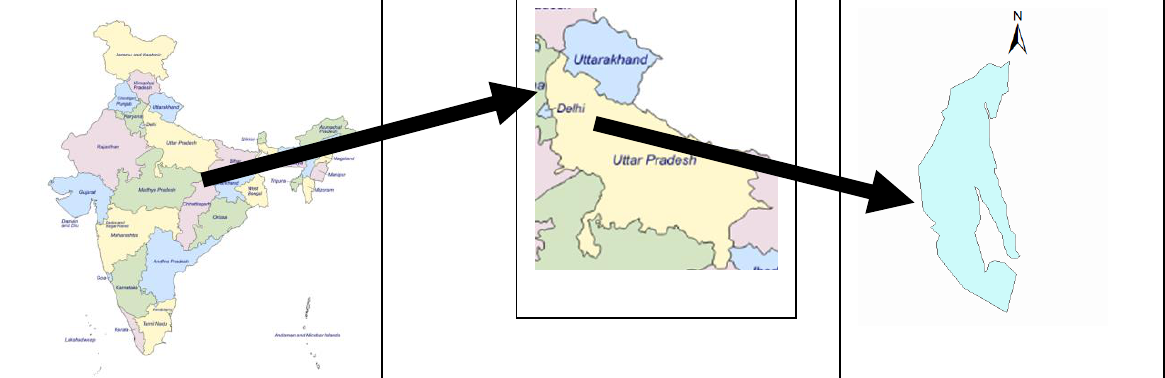
Figure 1. Upper Ganga Canal Command Area